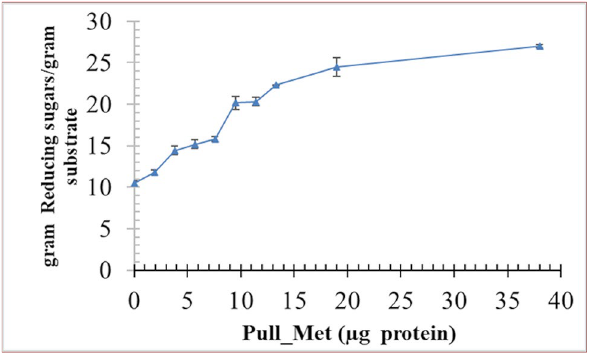
Table 3 Substrate specificity of Pull_Met Fig. 5 Synergistic action of gradual concentrations of Pull_Met with 21.28 U/mg CA-AM21 on raw ex potato starch saccharification. Values are the average of three readings ± SE.